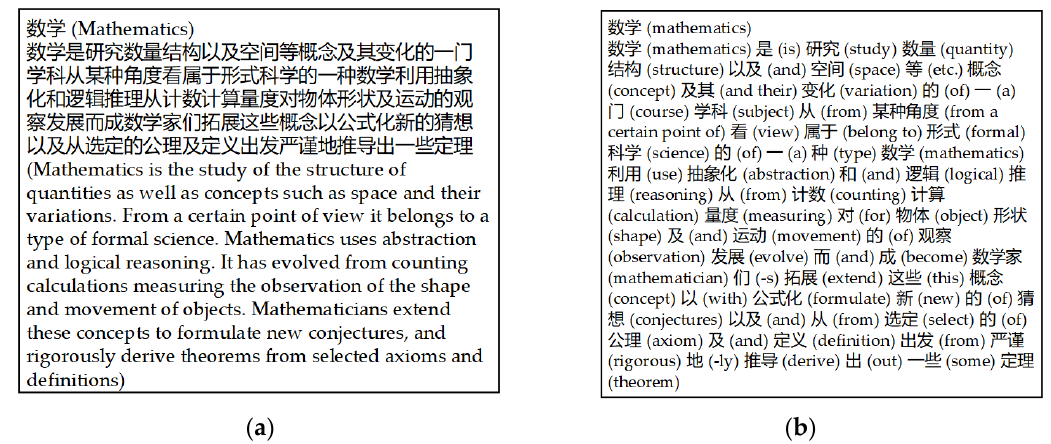
Figure 7. Original text after using LTP. ( a ) The original text; ( b ) After using LTP.